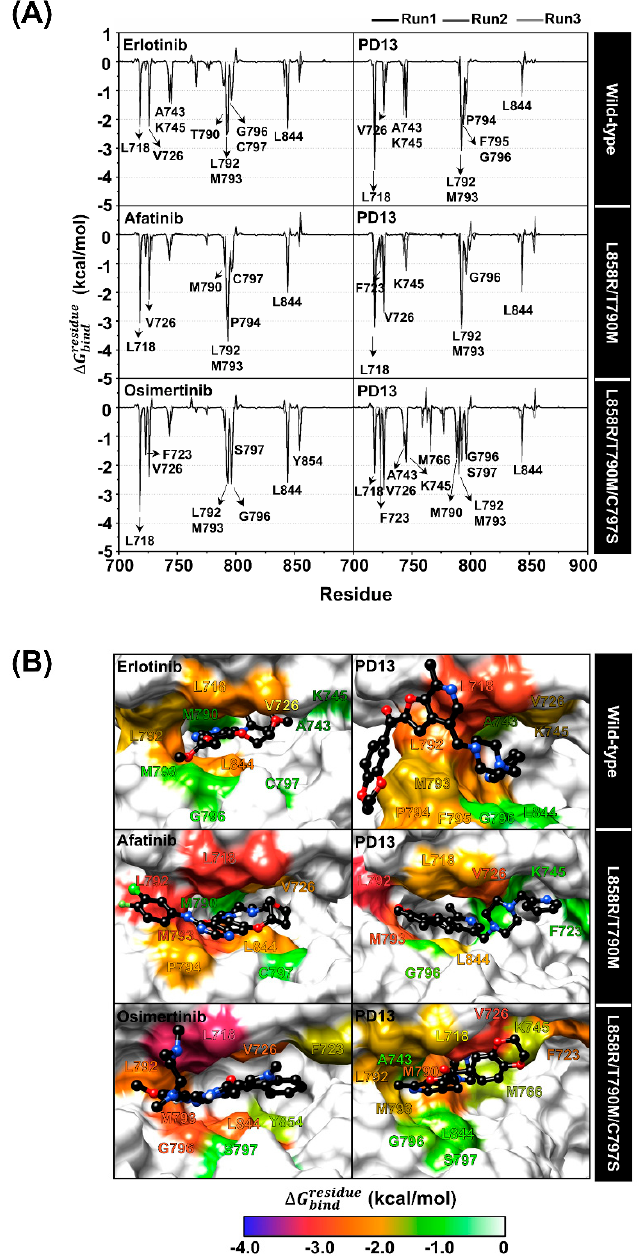
Figure 5. ( A ) Per-residue decomposition free energy of EGFRs for the binding of PD13 and drugs from three independent simulations ( top ). ( B ) The binding orientation of PD13 and drugs within the binding pocket of EGFR was drawn from the last snapshot. The lowest and highest energies are shaded from blue to white ( bottom ).